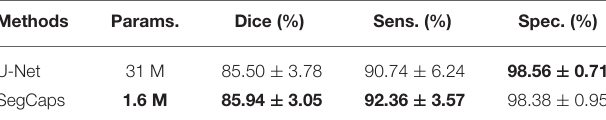
TABLE 1 | Comparison of Dice, Sensitivity (Sens.), and Specificity (Spec.) for different neural network models are given in mean ± standard deviation (SD)